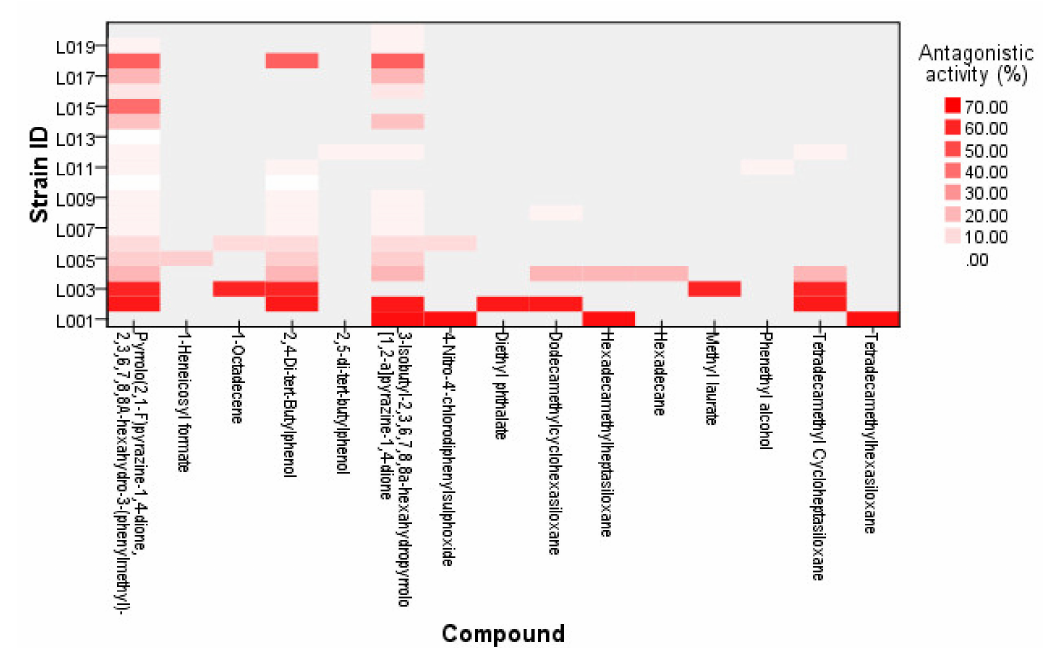
Figure 2. Heat map showing compounds from the lactic acid bacteria strains and antagonistic activities in some XDR Acinetobacter baumannii strains (in percentage, n =